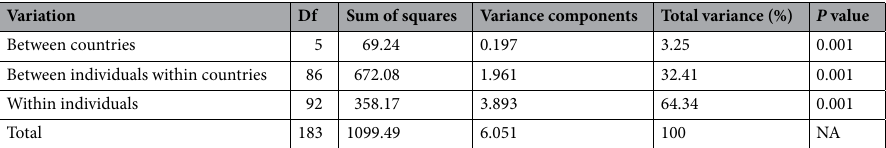
Table 4. Results of an amova to analyse differences between the six countries in this analysis based on the microsatellites. P value was calculated using a randomization test with 999